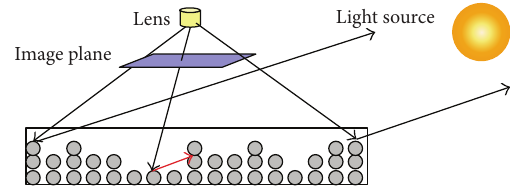
Figure 12: The simulation